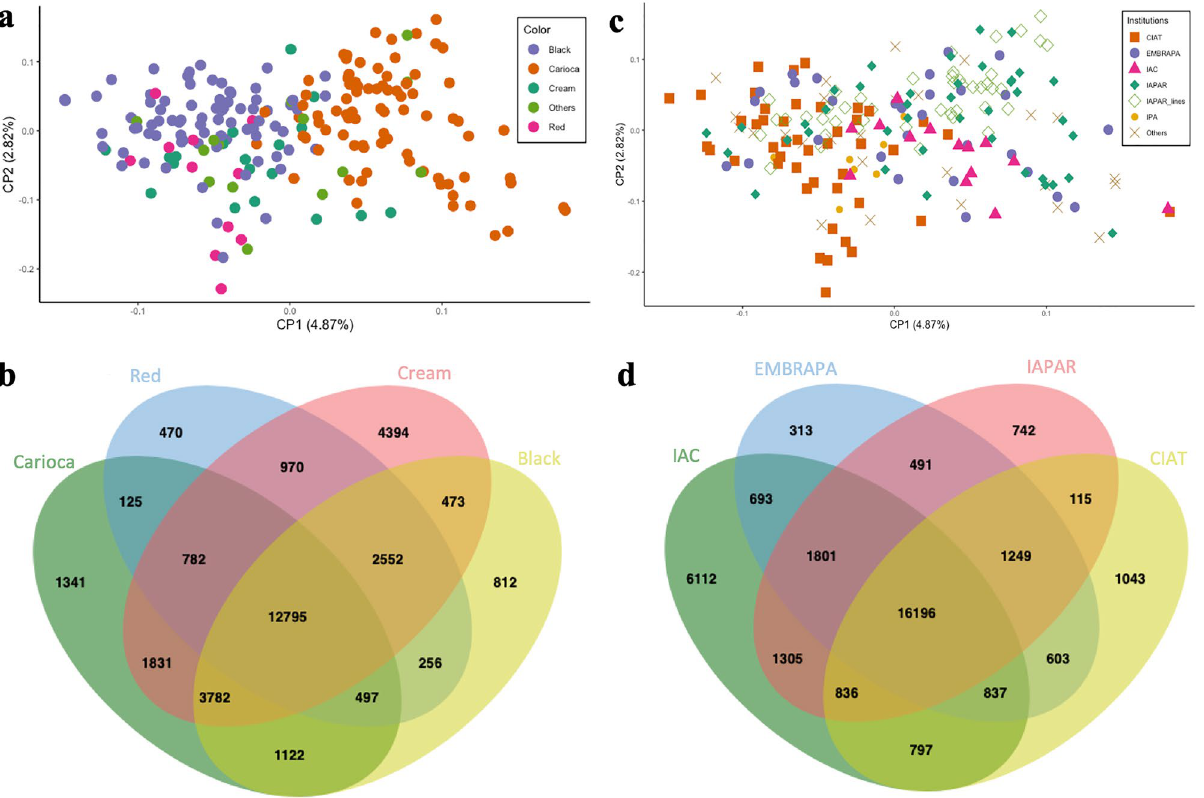
Figure 4. Principal component analyses and Venn diagrams. ( a ) Principal component analysis of 207 accessions of common beans of Mesoamerican origin with different seed tegument colors. ( b ) Venn diagram for the different sets of SNPs related to seed tegument color. ( c ) Principal component analysis of 207 accessions of common beans from different research institutions. ( d ) Venn diagram for the different sets of SNPs related to the institutions of origin. Figure ( a ) and ( c ) produced in R v.4.0 and Figures b and d produced in JVENN (http:// jvenn .toulo